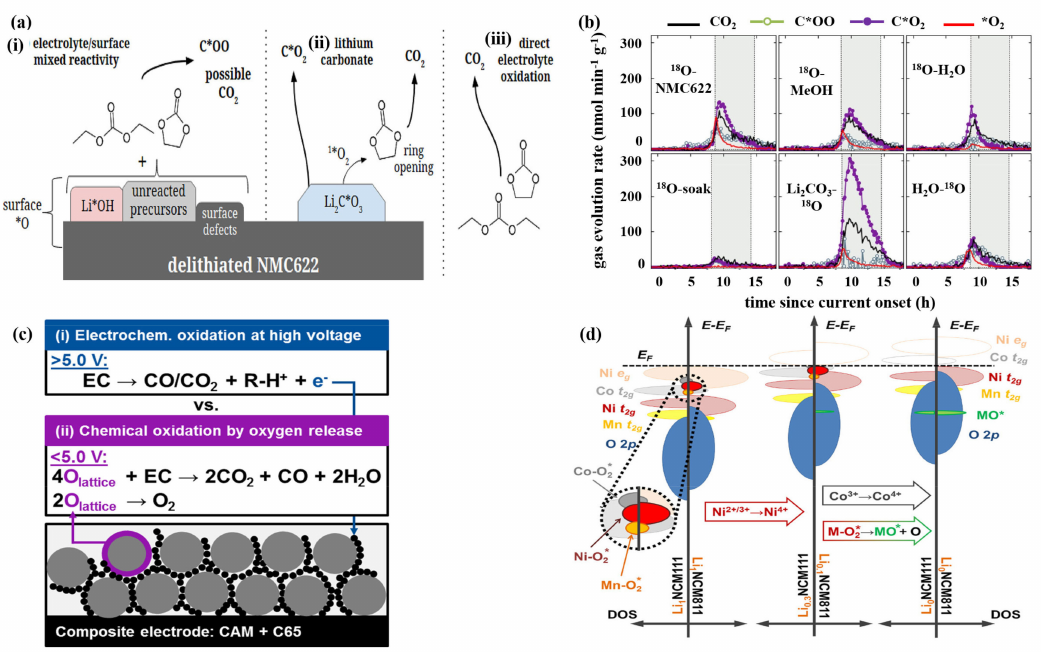
Figure 3. ( a ) The reasons for gas generation at the surface. “surface *O” indicates that the oxy- gen is from the surface of the NCM622 oxide or oxygen-containing impurities originally present on the surface (for example, Li*OH and Li 2 C*O 3 ), and “O” indicates that the oxygen is from the electrolyte. ( b ) Rate of gas evolution for NCM622 with different treatments ( 18 O–NCM622: the baseline sample synthesized via conventional procedure; 18 O–MeOH: sample treated by methanol rinsing; 18 O–H 2 O: sample treated by H 2 O rinsing; 18 O–soak: sample treated by H 2 O soaking; Li 2 CO 3 – 18 O: sample treated by Li 2 CO 3 enriching; H 2 O– 18 O: sample treated by H 2 O washing and 18 O enriching). Reproduced with permission from ref. [39]. Copyright 2019 American Chemical Society. ( c ) Proposed gassing mechanisms in high-voltage lithium-ion cells. Reproduced with per- mission from ref. [40]. Copyright 2017 American Chemical Society. ( d ) Qualitative DOS diagrams for NCM111 and NCM811 at full lithiation, maximum nickel oxidation, and complete de-lithiation. “M-O 2 *” refers to the energy states of surface species. Reproduced with permission from ref. [23]. Copyright 2017 American Chemical